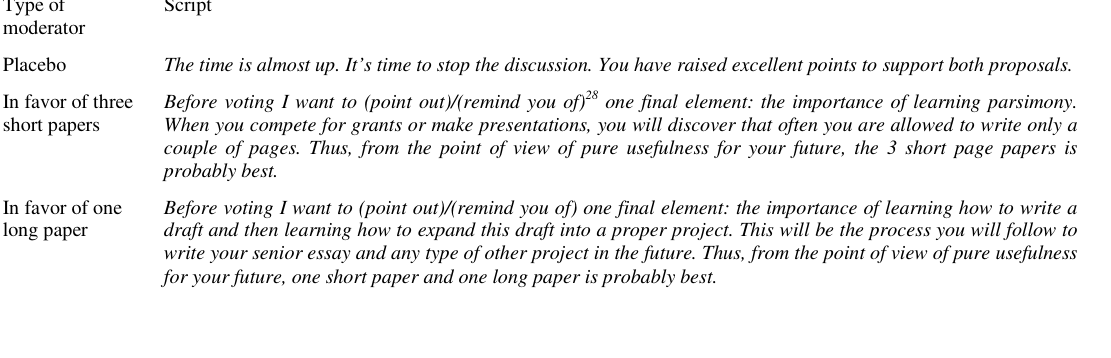
Table A4: First discussion, final